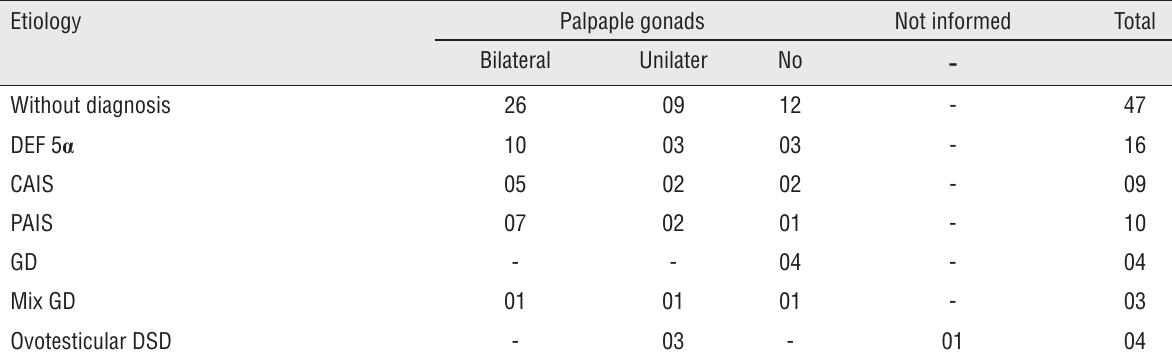
gD = Gonadal disgenesia; cAIs = Complete androgen insensitivity syndrome; pAIs = Partial androgen insensitivity syndrome; DEf5 α = Deficiency of 5 α reductase; Ovotesticular DSD-ovotesticular disturbance of sexual